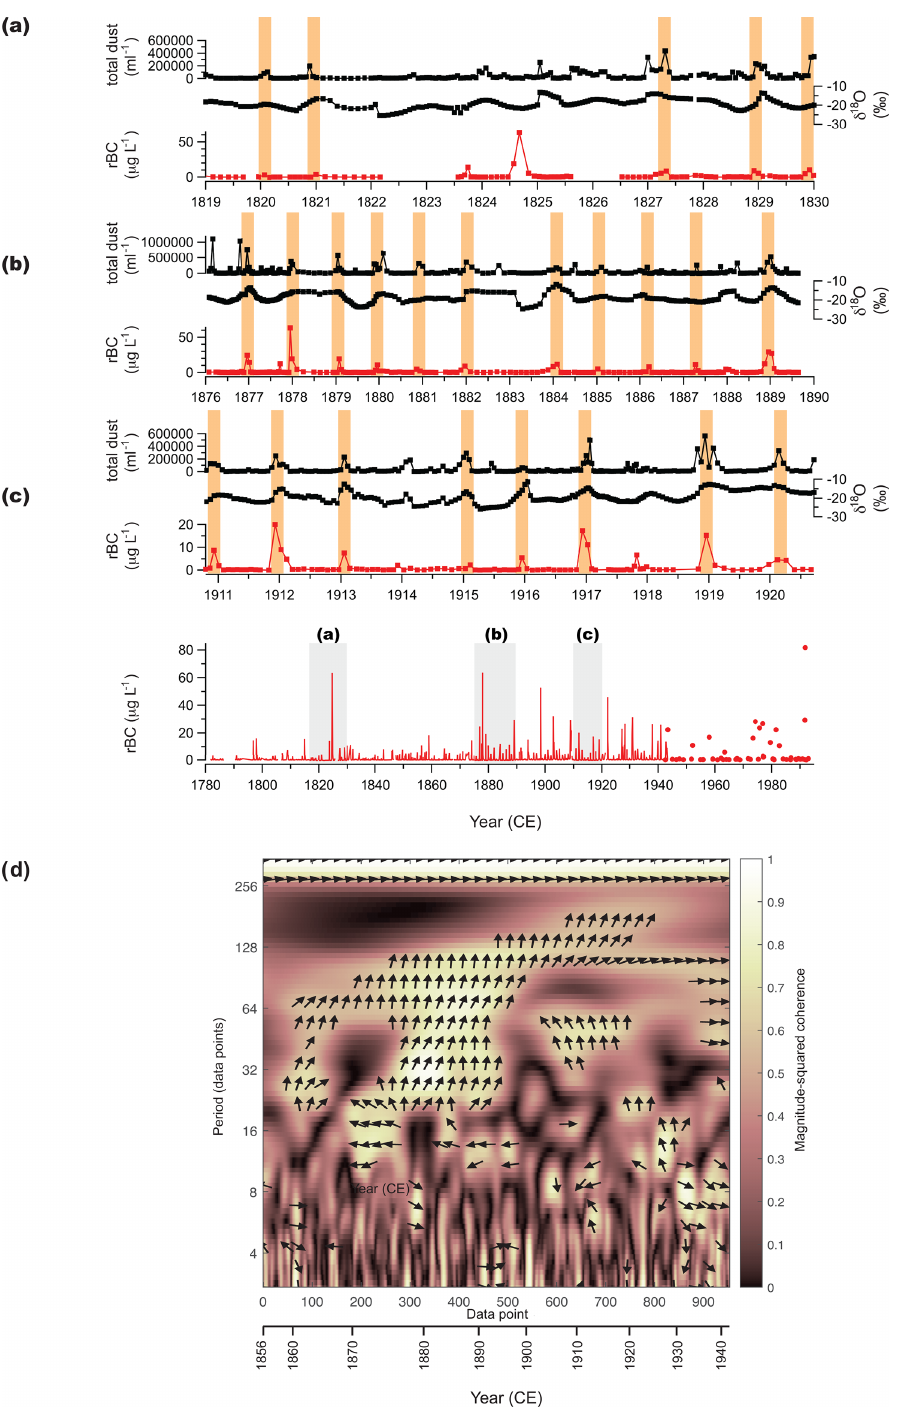
Figure 3. Peaks in the rBC record compared to the total dust and δ 18 O records (Thompson et al., 2000) over three time intervals ( a : 1819– 1830, b : 1876–1890, c : 1911–1921CE) in the Dasuopu ice core. Note that peaks in the rBC record are associated with depleted δ 18 O and increased dust deposition. The spectral coherence between rBC and δ 18 O between 1856 and 1943CE (d) shows strong magnitude-squared coherence at a long period ( ∼ 21 years) with no phase lag (as shown by arrows oriented in radian space (i.e., the arrow oriented to the right indicates no phase lag; arrows oriented to the left indicate an antiphase relationship), strong magnitude-squared coherence between 2 and 10 years with a 0.5–2.5-year phase lag between 1878 and 1900CE, and strong magnitude-squared coherence with no phase lag between 1910 and